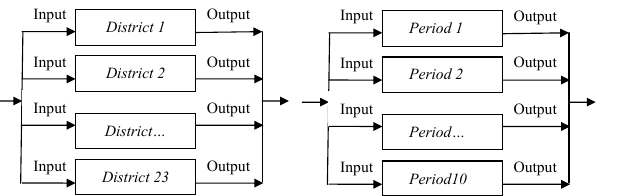
Fig.7.The flood affected area(left),suffered population(middle) and economic loss(right) regional variation